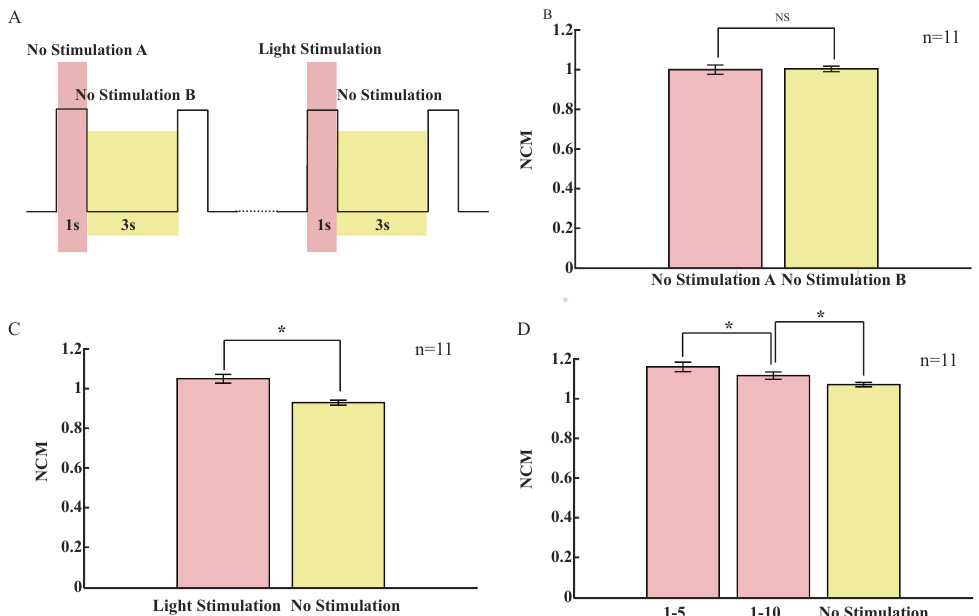
Figure 3. Response to periodic light stimulation. ( A ) Diagram illustrating the stimulus. Flies were subjected to 1 s of light stimulation at 3 s intervals. ( B ) Average 20–30 Hz NCM ( ± SEM) during no stimulation A (yellow) and no stimulation B (red); n = 11 flies; the first five cycles were recorded. ( C ) Average 20–30 Hz NCM ( ± SEM) during no stimulation (yellow) and light stimulation (red); n = 11 flies; the first five cycles were recorded. ( D ) Average 20–30 Hz NCM ( ± SEM) for cycles 1–5 (red) and 1–10 (red) and average 20–30 Hz NCM ( ± SEM) during the no-stimulus period (yellow) in the first 10 cycles; n = 11 flies. Significance was defined by two-tailed t -test; *, p < 0.05; NS, p > 0.05. 1.2